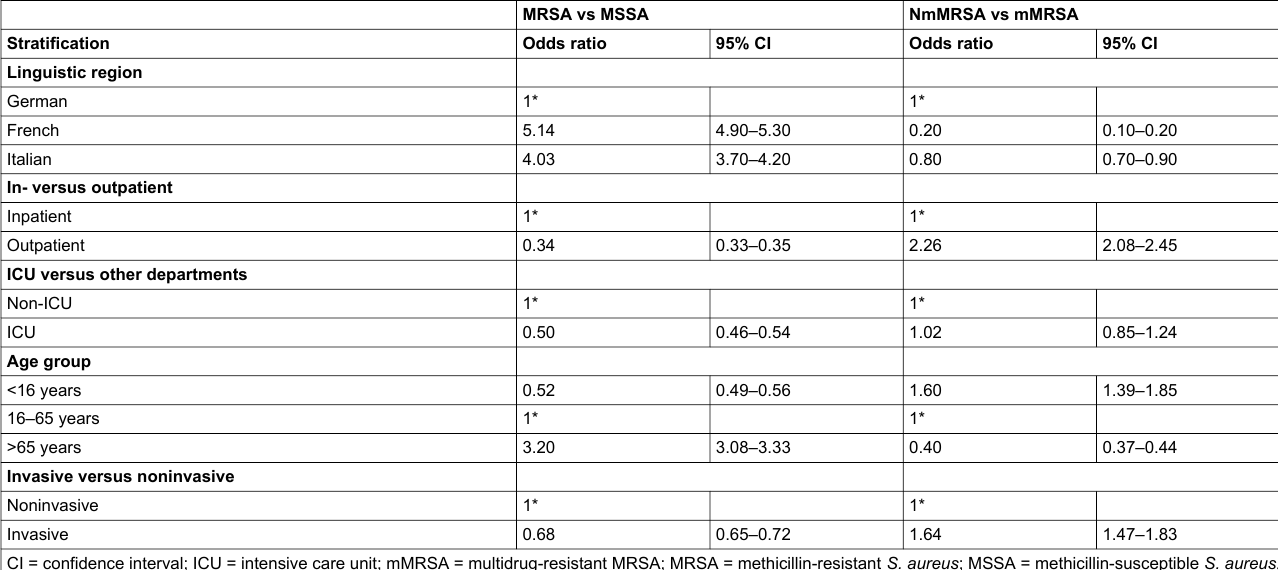
Table 2A: Risk factors for MRSA (vs MSSA) and NmMRSA (vs mMRSA) by univariable logistic regression analysis.